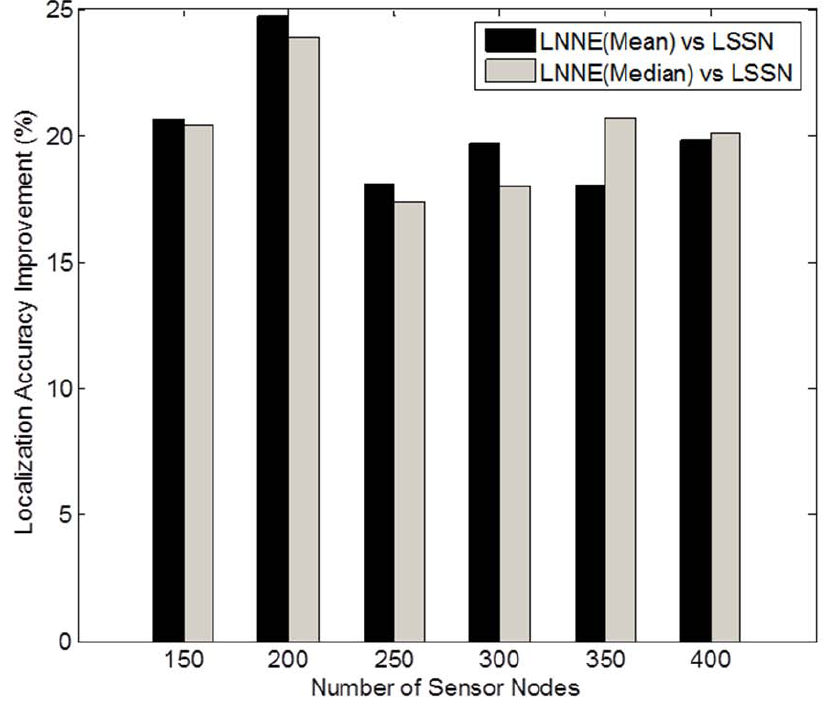
Figure 7. Performance improvement of LNNE vs. LSSN under different network densities ( N = 150 to 400, beacon ratio = 0.2, no coverage